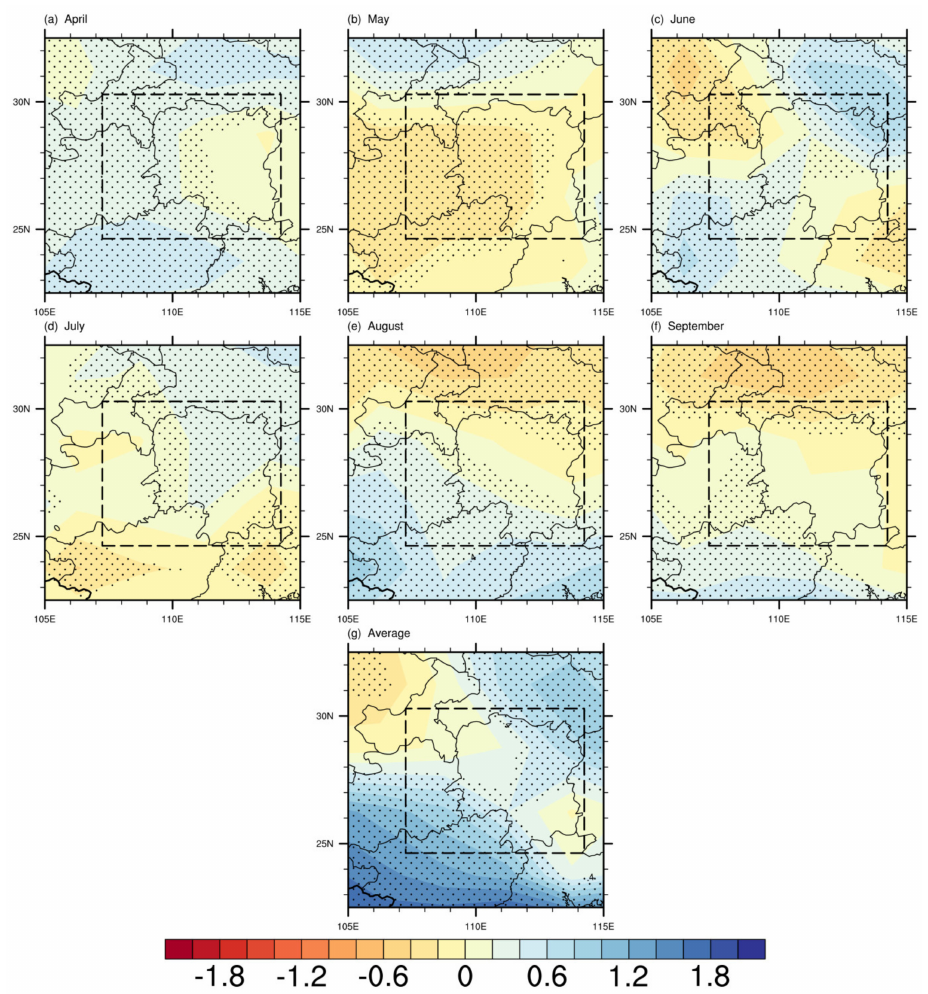
Figure 6. Trend distribution of the precipitation, unit: mm/year; the dotted area indicates that it passed the 95% significance